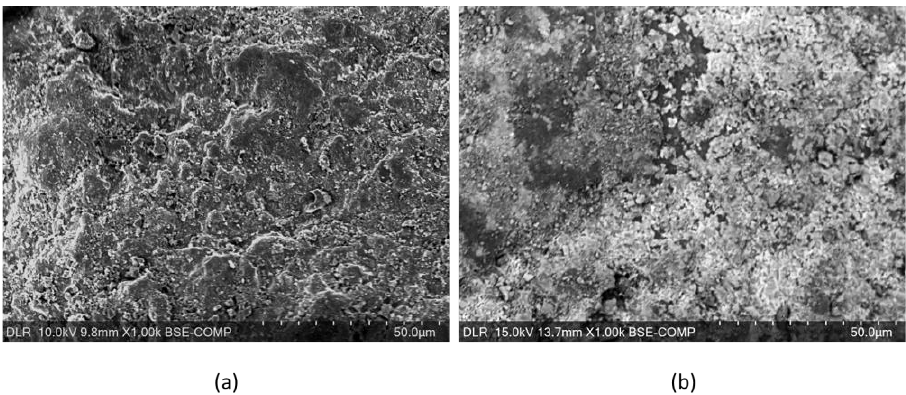
Figure 10. SEM Microstructures revealing the surfaces of ( a ) uncoated and ( b ) coated proppants after 4 h of abrasion